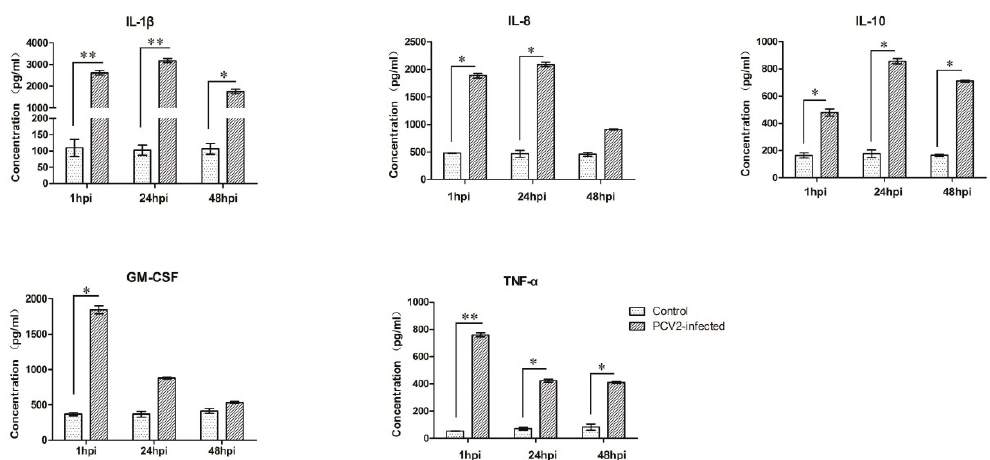
Figure 3. Validation of PCR array data by porcine cytokine array system. PCV2-induced changes in the secreted levels of IL-1 β , IL-10, IL-8, GM-CSF, and TNF- α in the culture supernatants of control and PCV2-infected PAMs were measured using a RayBiotech fluorescent Quantibody ® porcine cytokine array system. Data are mean ± SE of three independent experiments. * represents p < 0.05, ** represents p < 0.01.